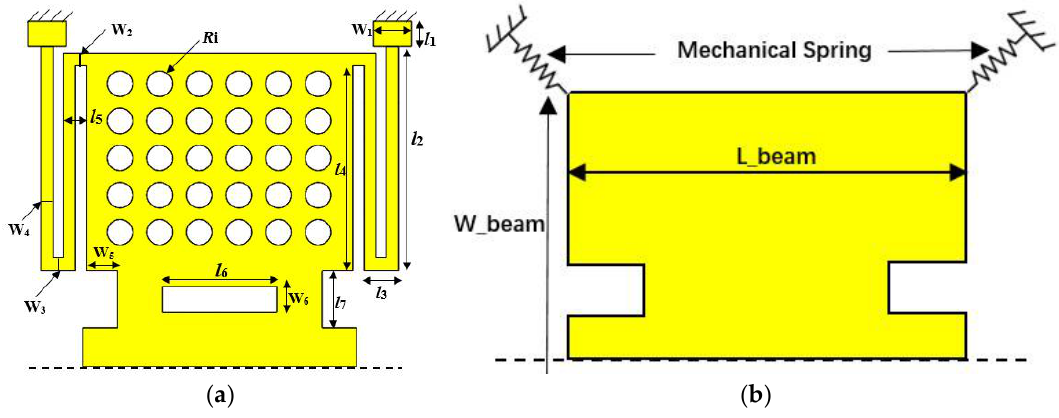
Figure 5. ( a ) Detailed size of the switch; ( b ) equivalent model of switch [16]. The pull-down voltage of proposed switch is [18]: